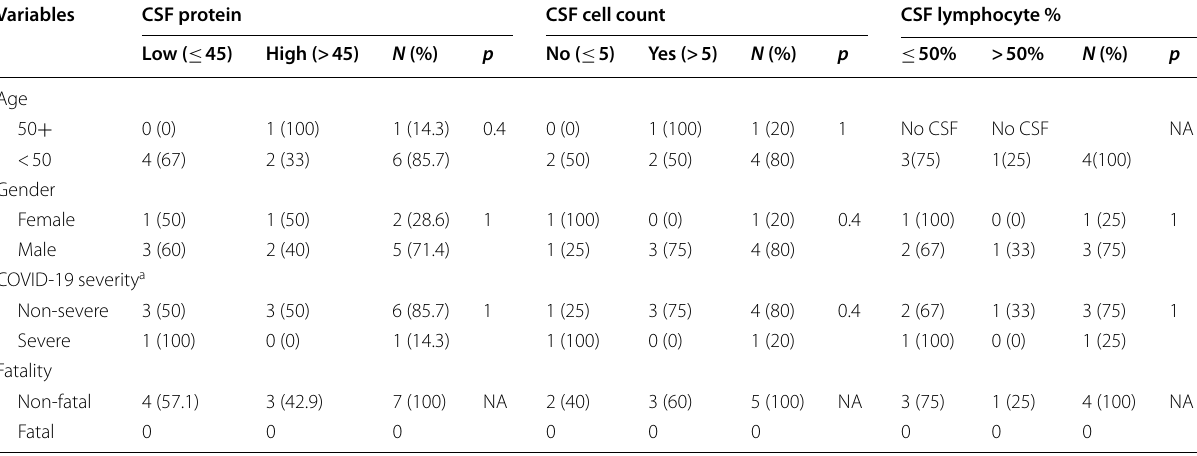
CSF cerebrospinal fluid, NA not applicable P values were calculated from Fisher’s exact test. All observations were non-fatal and thus a Fisher’s exact test was not available between fatality and the outcomes of